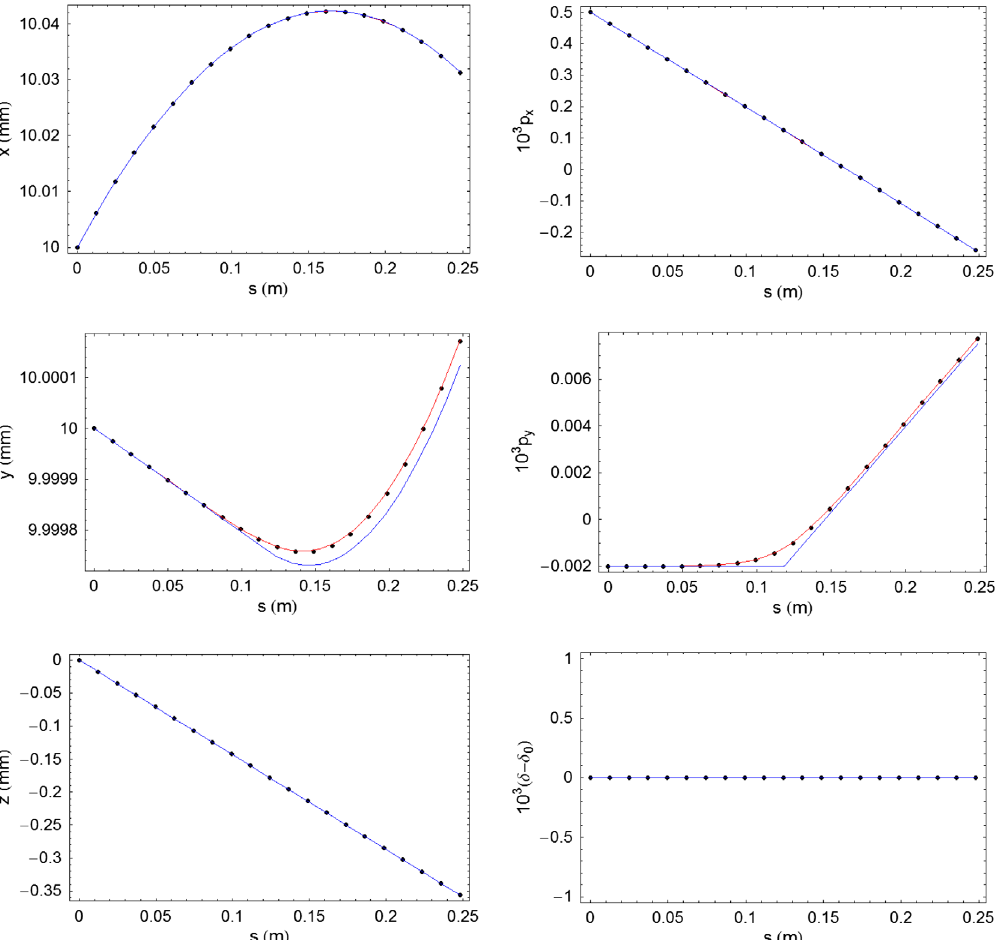
FIG. 11. Trajectory of a muon through the fringe-field region of an electrostatic quadrupole in the g − 2 storage ring. The electrostatic potential is shown in Figs. 8 and 9. The reference momentum is 3 . 094 GeV =c , and the reference trajectory is the arc of a circle with a radius of 7.112 m, determined by the magnetic field strength B ≈ 1 . 45 T. The initial coordinates ð x; p ð 10 mm ; 5 × 10 − 4 ; 10 mm ; − 2 × 10 − 6 ; 0 ; − 0 . 02 Þ . The black points show the results from the symplectic integrator, with a step size of 12.4 mm, i.e., a total of 20 steps. The red line shows the results of an integration using a (nonsymplectic) adaptive Runge-Kutta integration of the equations of motion in the same field. The blue line shows the results of a Runge-Kutta integration of the equations of motion through a region with the same magnetic field but with a hard-edge model for the electric